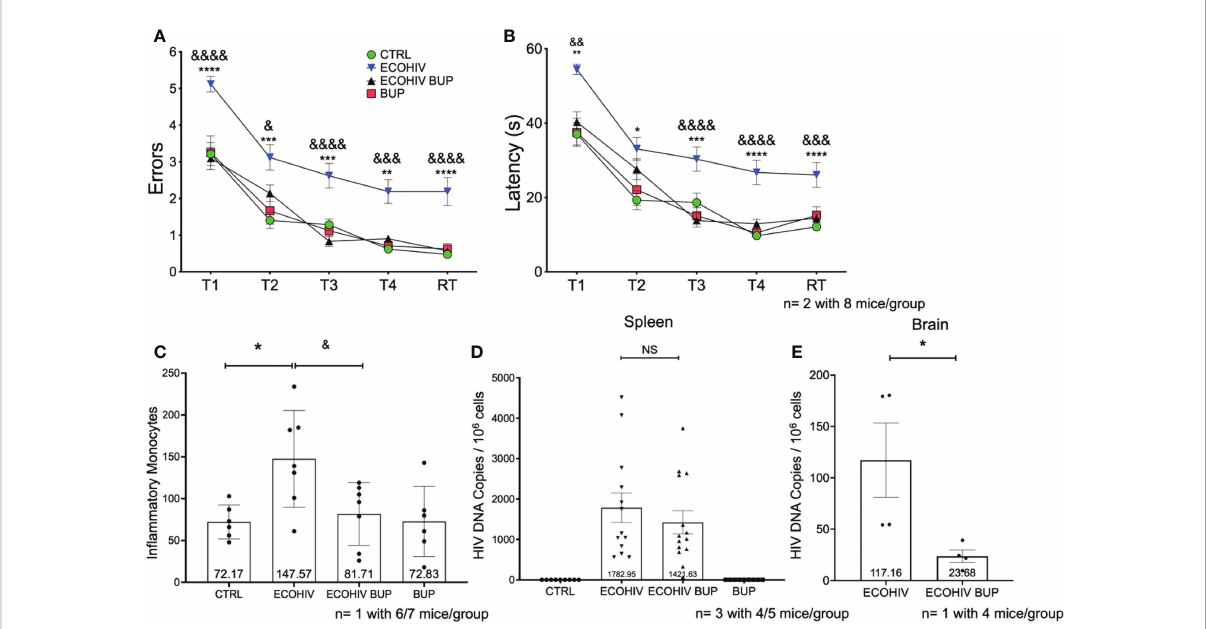
FIGURE 2 Buprenorphine reverses cognitive impairment, decreases in fl ammatory monocytes and HIV DNA in the brain when given two weeks post- EcoHIV infection. C57BL/6J mice in each experimental group; CTRL (green circles), ECOHIV (blue inverted triangles), ECOHIV BUP (black triangles), and BUP (red squares) were tested using a radial arm water maze. Mice were infected for two weeks before buprenorphine injections began. After an additional two weeks, mice were assayed for cognitive performance using the RAWM (A, B) . EcoHIV infected mice were cognitively impaired after four weeks of infection as these mice made signi fi cantly more errors (A) and took signi fi cantly longer (B) to fi nd the hidden platform compared to both CTRL (*) and ECOHIV BUP (&) groups. Data are shown as mean+/- SEM from the last three days of water maze testing. There were a total of two independent experiments, each with eight mice/group for a total of 16 mice in the CTRL, ECOHIV, and ECOHIV BUP groups. One independent experiments was performed with 8 mice for the BUP group (A, B) ECOHIV vs CTRL, **p<0.005, ****p<0.0001. ECOHIV vs ECOHIV BUP, & p<0.05, && p<0.005, &&& p<0.0005, &&&& p<0.0001. (C) , Immune cells from the brains of six to seven mice in each group in one independent experiment that underwent water maze testing were isolated and the number of in fl ammatory monocytes quanti fi ed by fl ow cytometry. The data are shown as mean +/- SD and analyzed using a one way ANOVA. There is a signi fi cant increase (147.57 +/- 57.83) in the number of in fl ammatory monocytes in the brains of EcoHIV infected mice compared to control (72.17